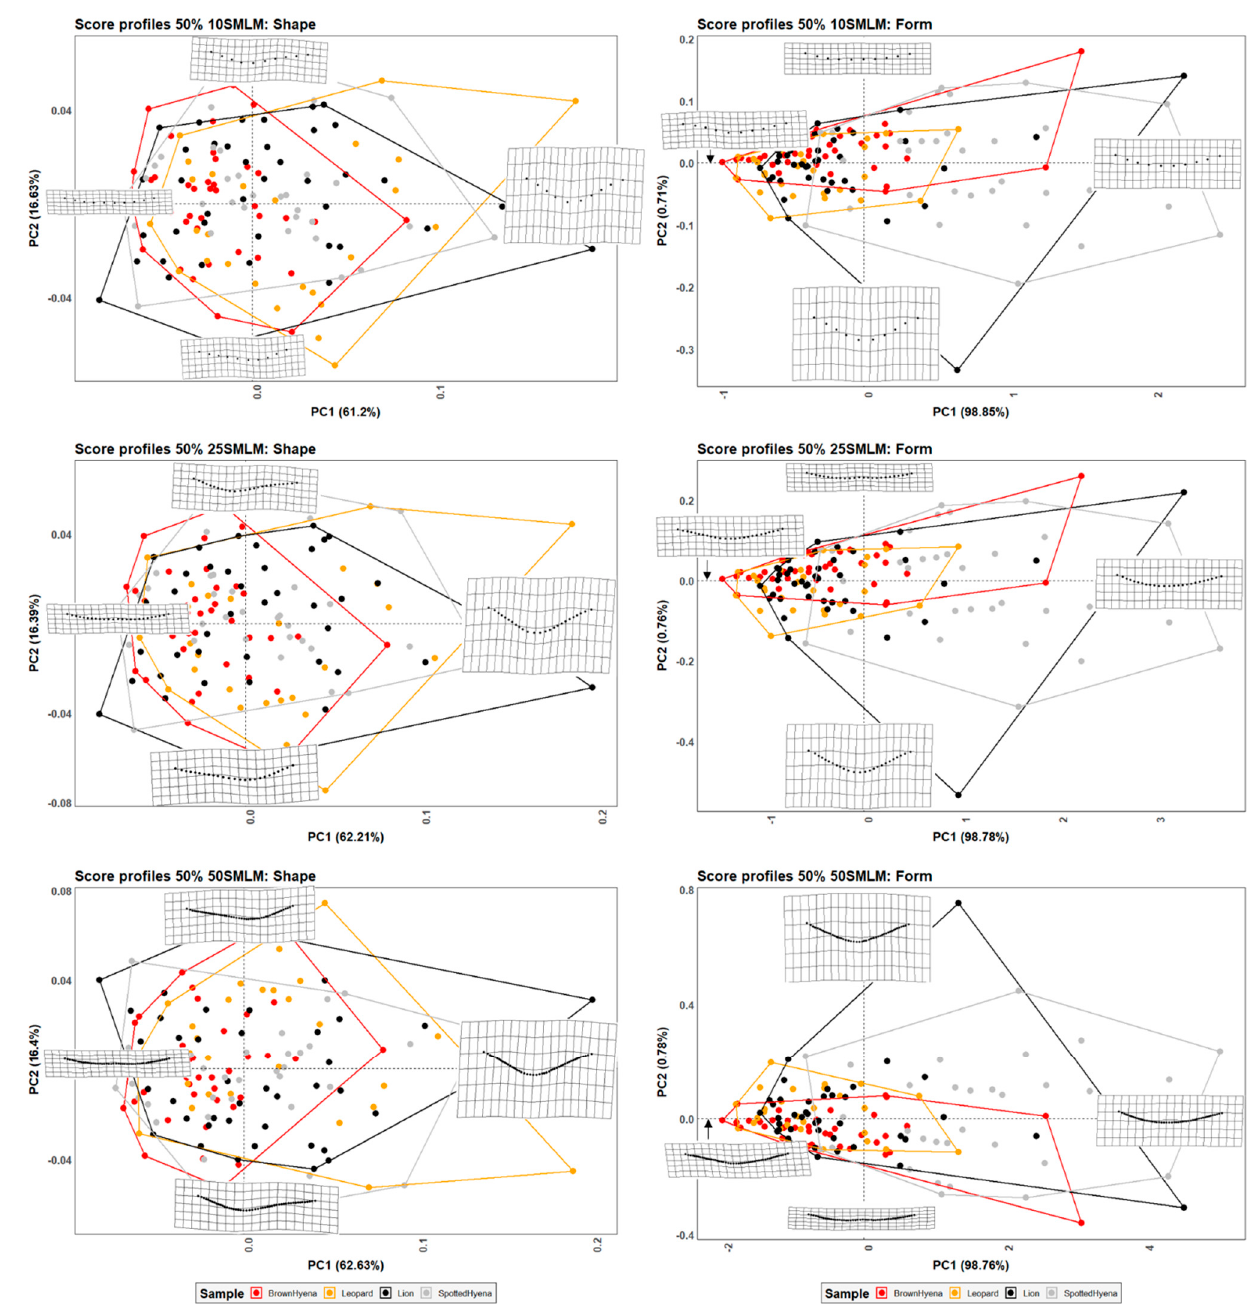
Figure 3. PCA plots in shape and form space on the single-curve semilandmark models at 50% cross-sectional score length, using 10 points; 25 points; and 50 points. Extreme changes in shape and form along PC1 and PC2 are illustrated with the aid of transformation grids.